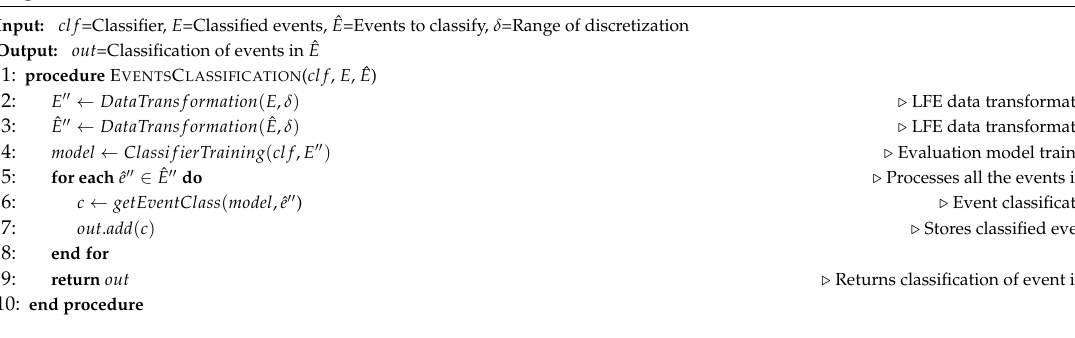
Algorithm 1 LFE events classification